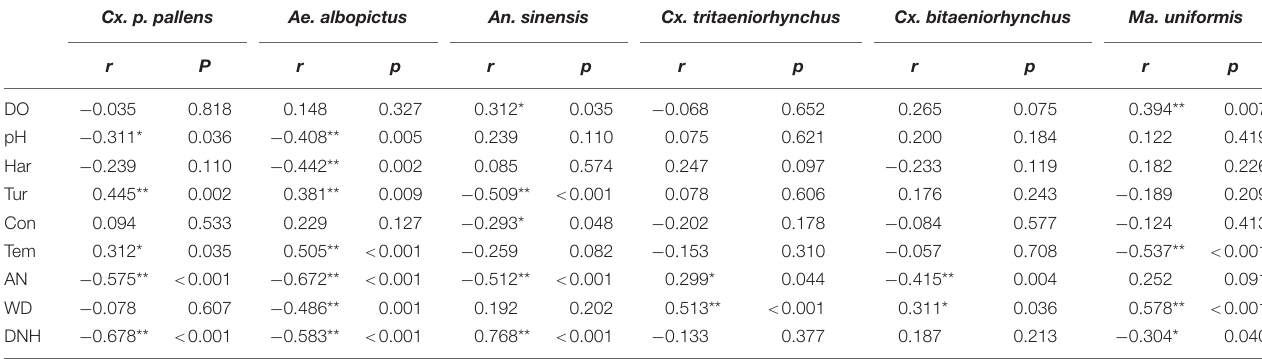
TABLE 4 | Spearman correlation coefficient between larval density and physicochemical characteristics of larval habitats.